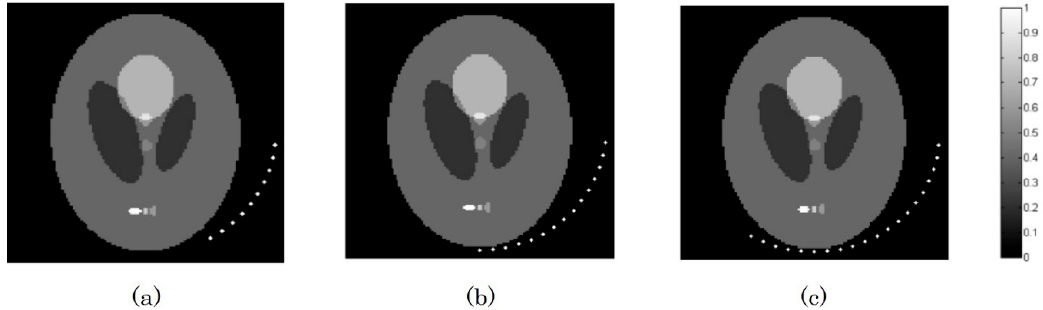
Figure 6. The diagram for the limited-angle circular scanning with: 60-views ( a ); 90-views ( b ); and 120-views ( c ).